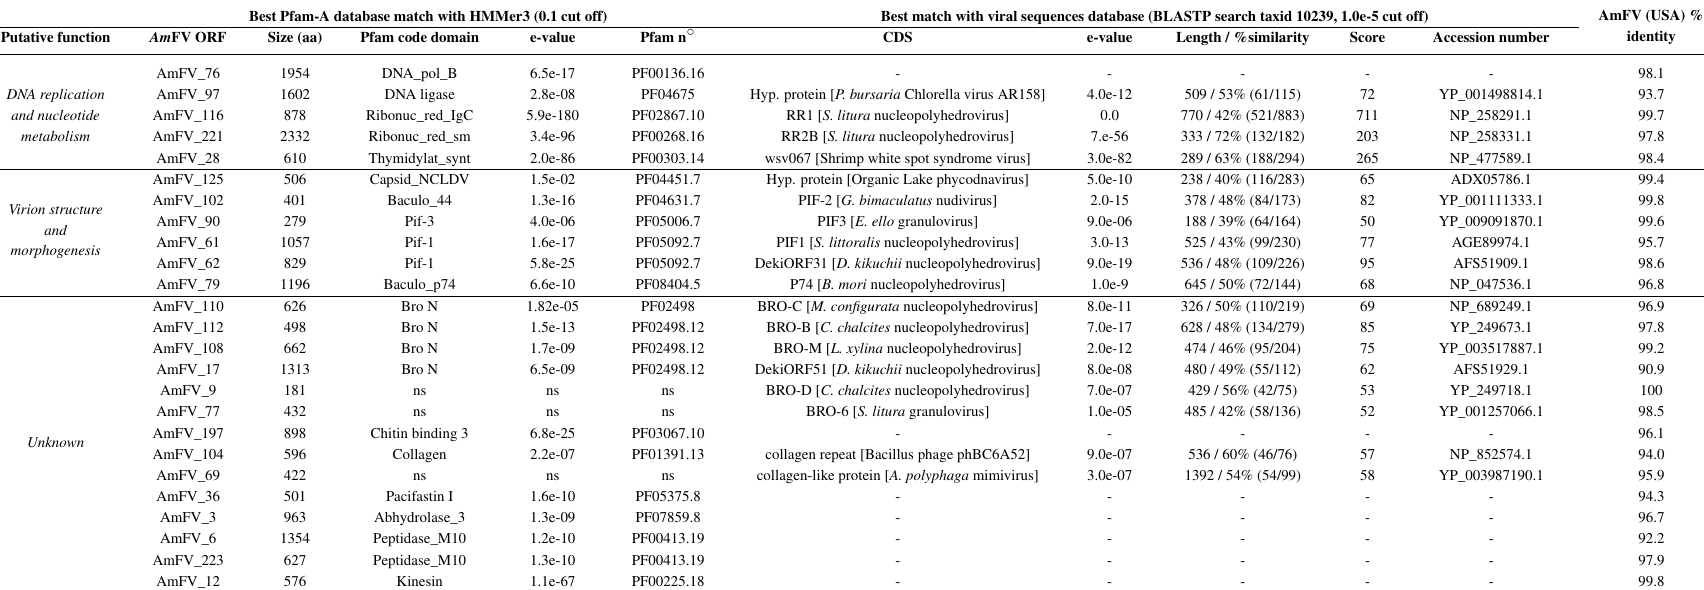
Table 1. Putative homologies of methionine initiated ORFs, with a minimum length of 100 amino acids, identified throughout the AmFV genome (best match against Pfam-A database with Hmmer3 ( left ) and corresponding best BLASTP match against viral sequences ( right )). Records with e-value under threshold are indicated with a dashed line. The percent identity at the amino-acid level between Swiss and US protein sequences are noted on the